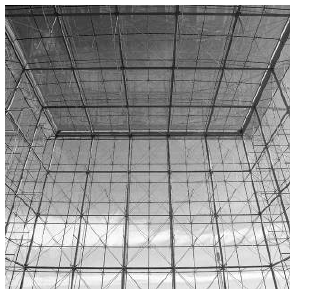
Figure 19: Inside view Figure 20: Glass Cube Santander Bank, Madrid